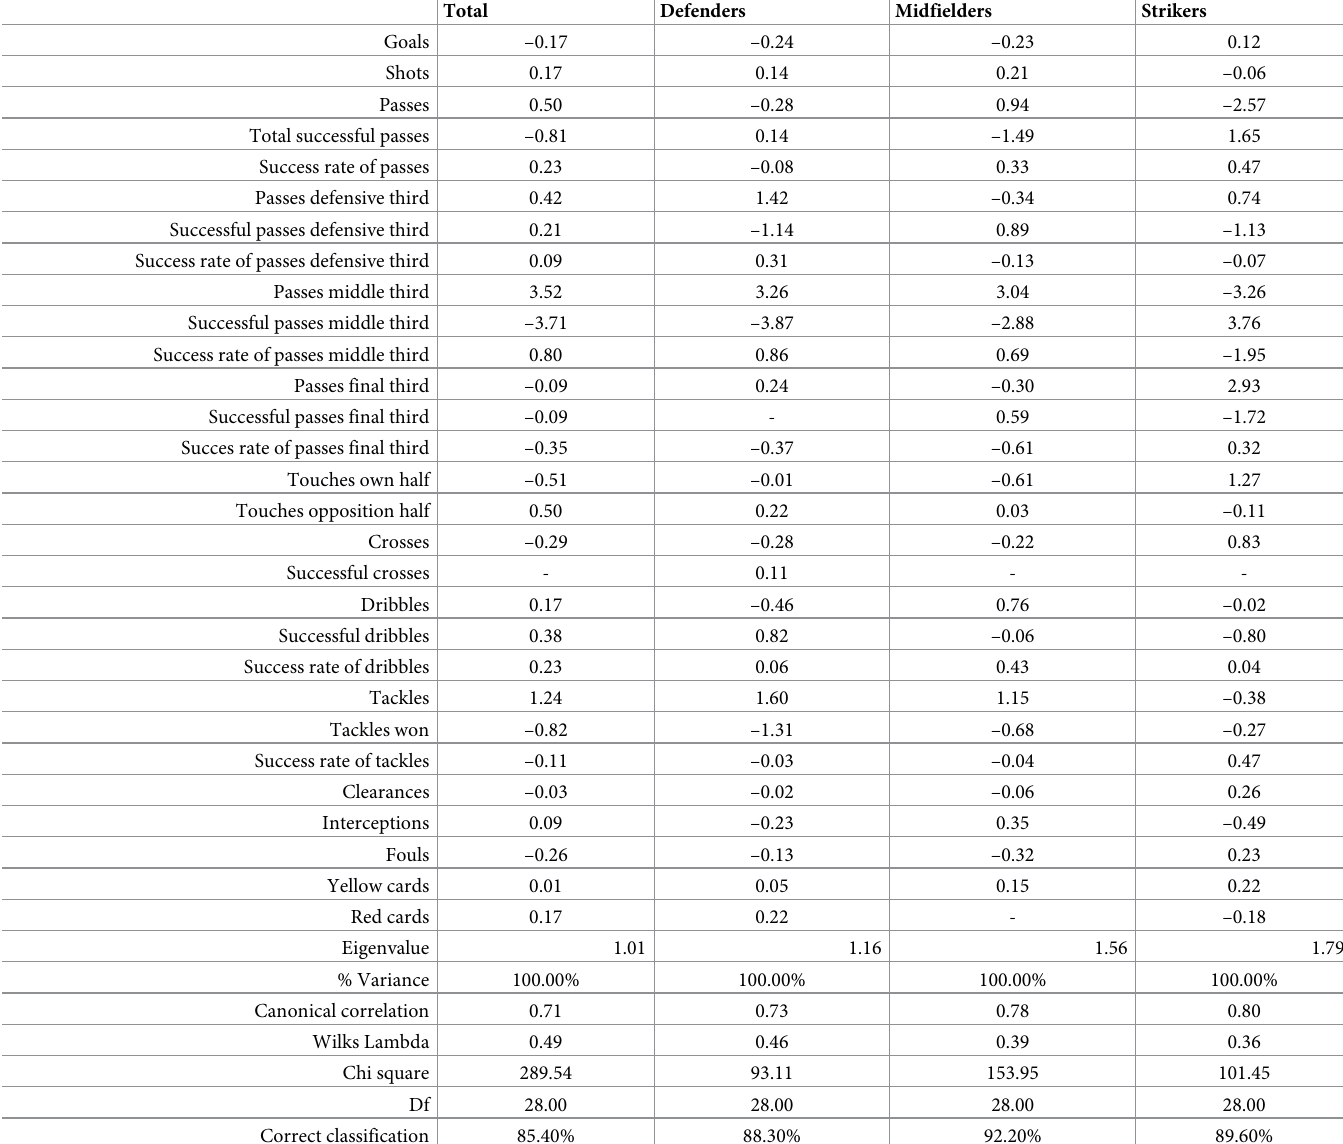
Table 3. Discriminant analysis between field positions at the FIFA Women’s World Cup 2011 and